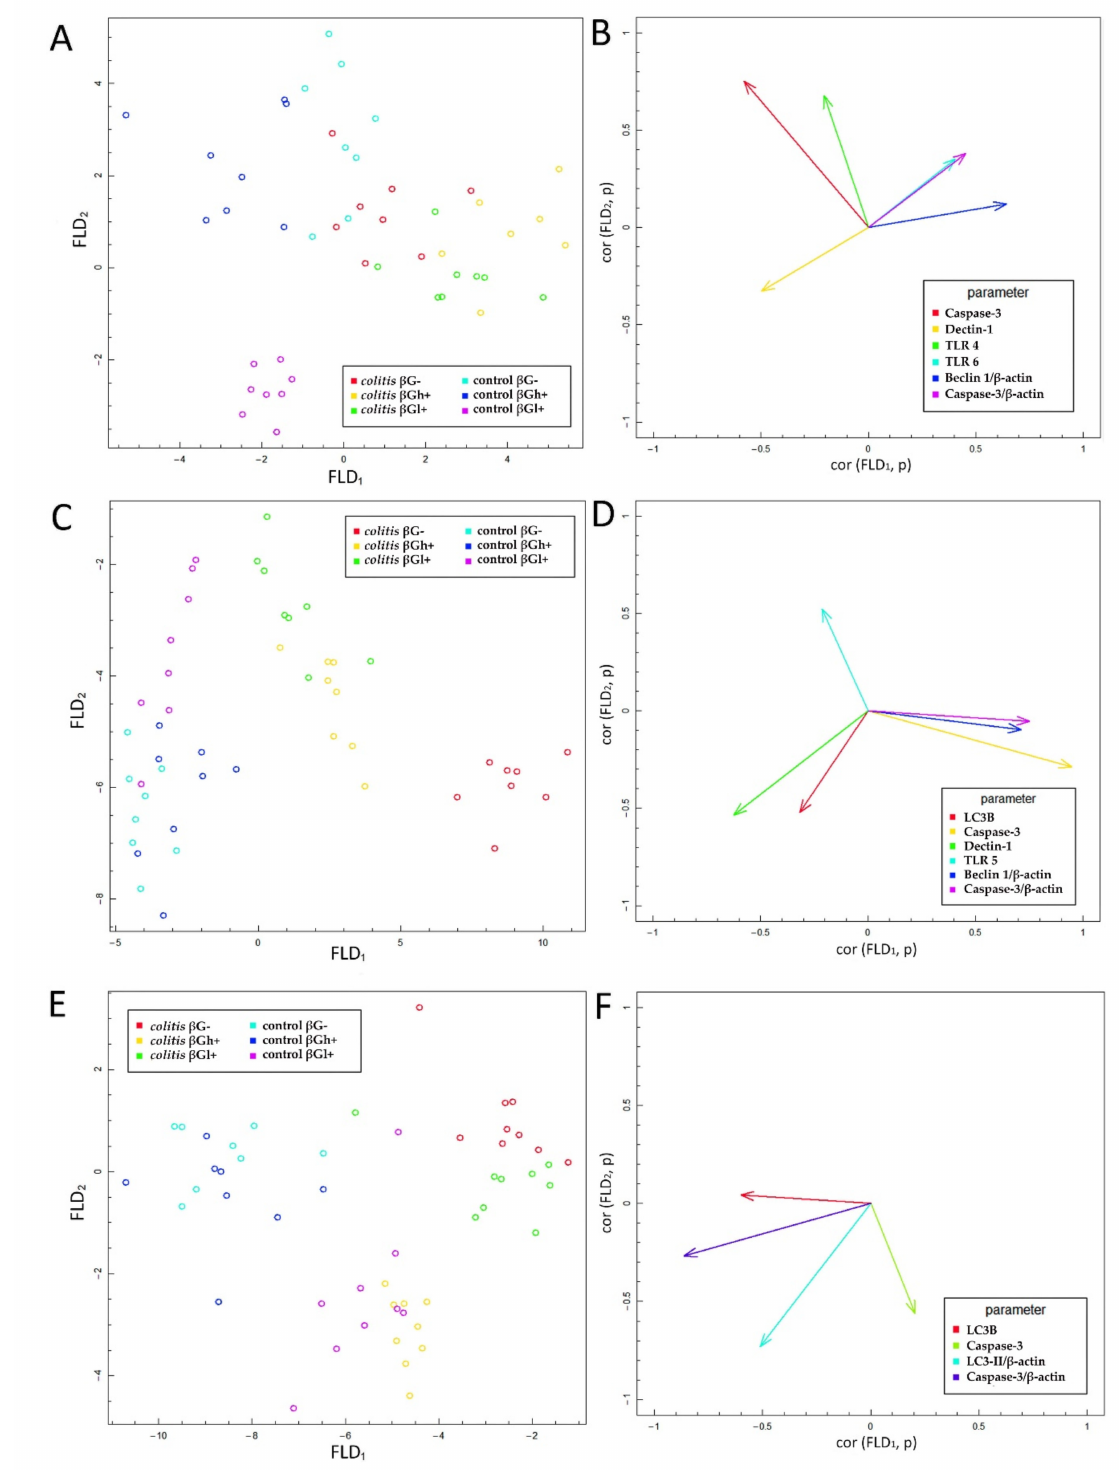
Figure 7. Fisher’s linear discriminant (FLD) analysis. ( A , C , E )—Experimental data on the plane spanned by two of the most data-separating FLDs. ( B , D , F )—Parameters contributing the most to the FLDs. Scheme ( A , B ): 3. days; ( C , D ): 7 days; ( E , F ): 21